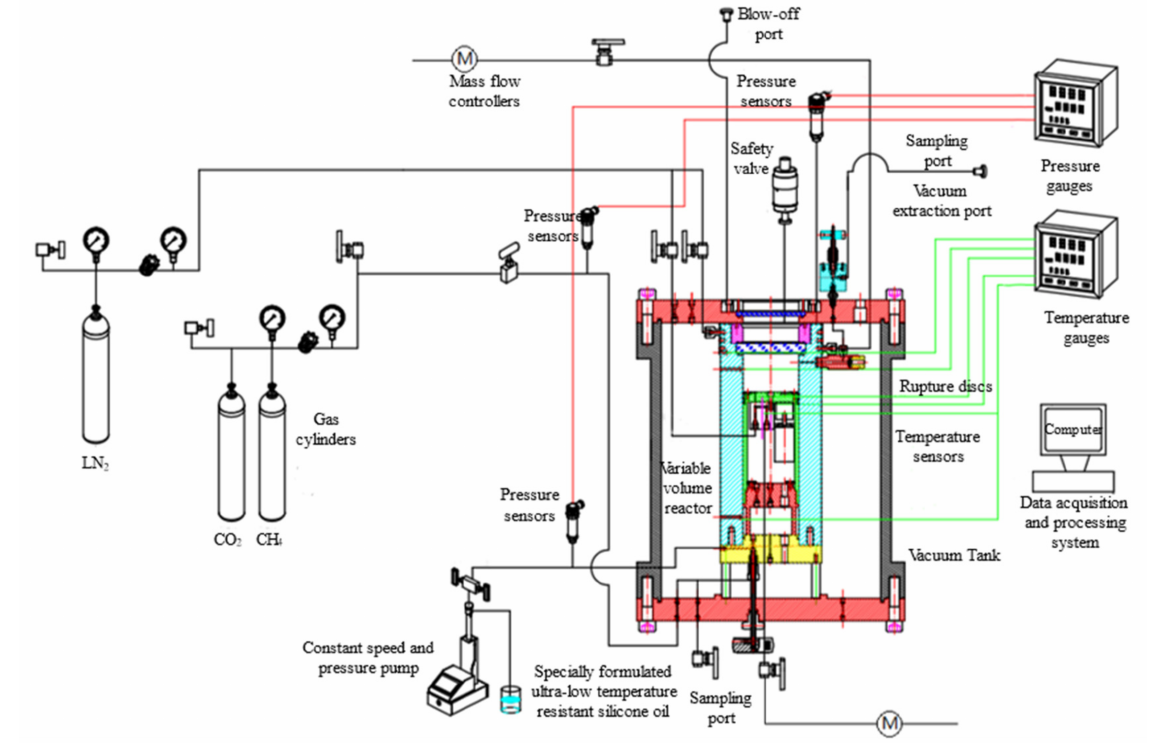
Figure 9. Flow chart of device and